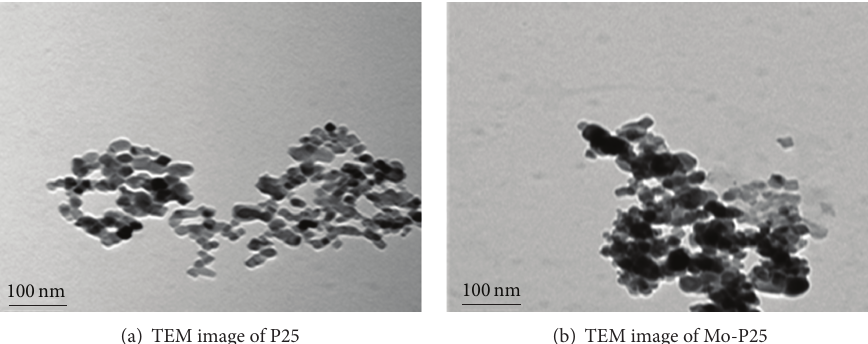
Figure 6: TEM images of P25 and Mo-P25.